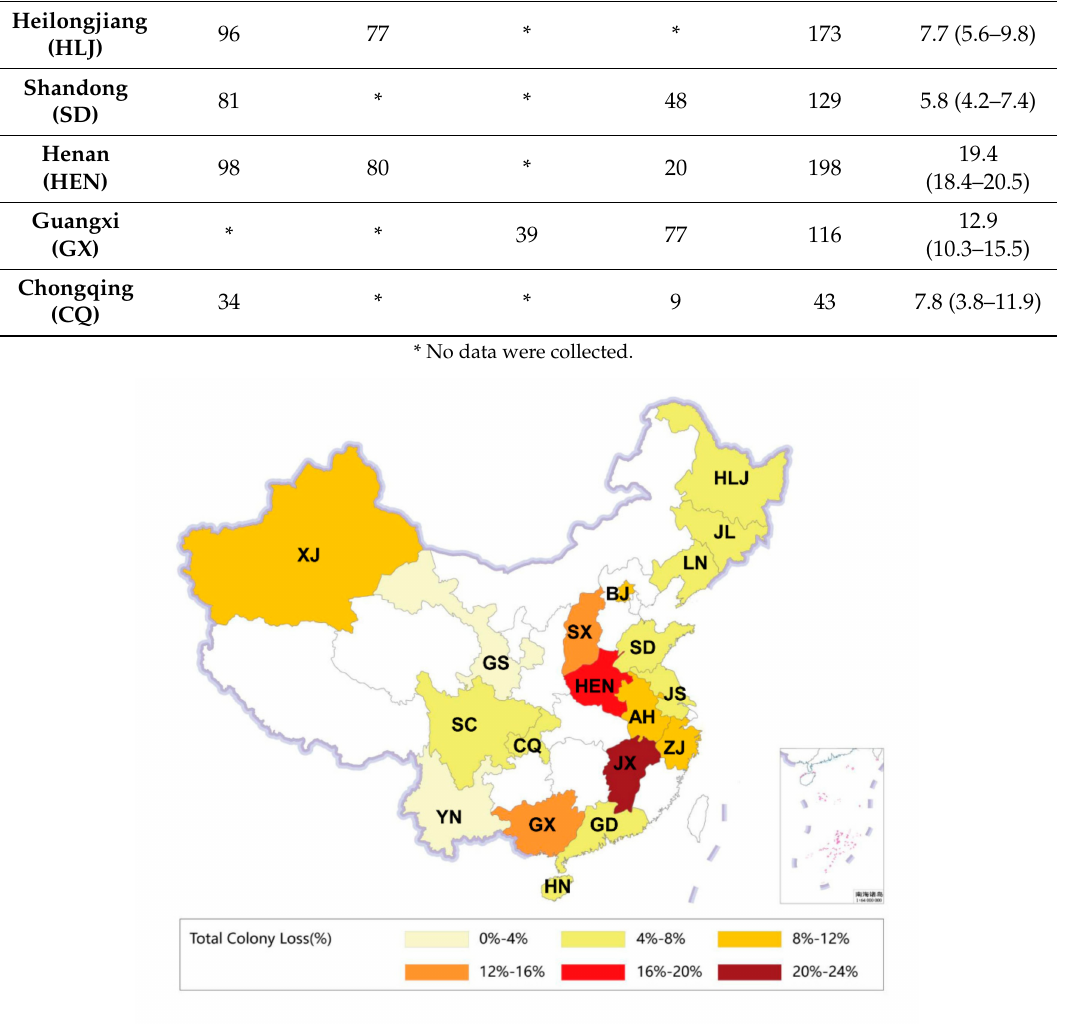
Figure 4. Total colony winter losses (%) by di ff erent provinces of